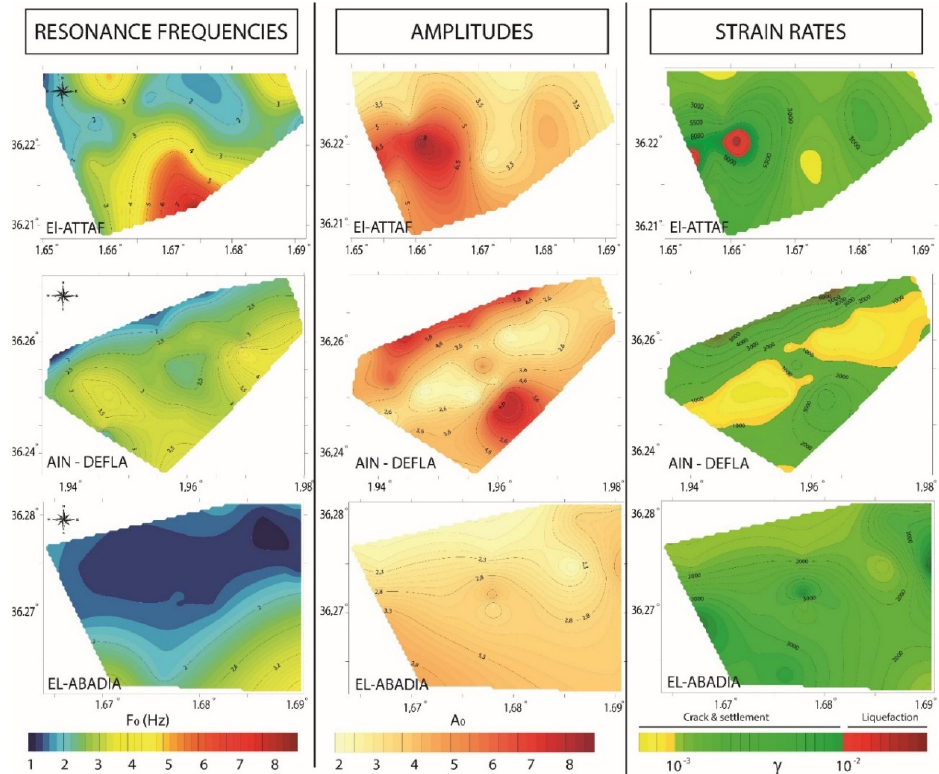
Figure 6. Results of the single − station measurements analysis.